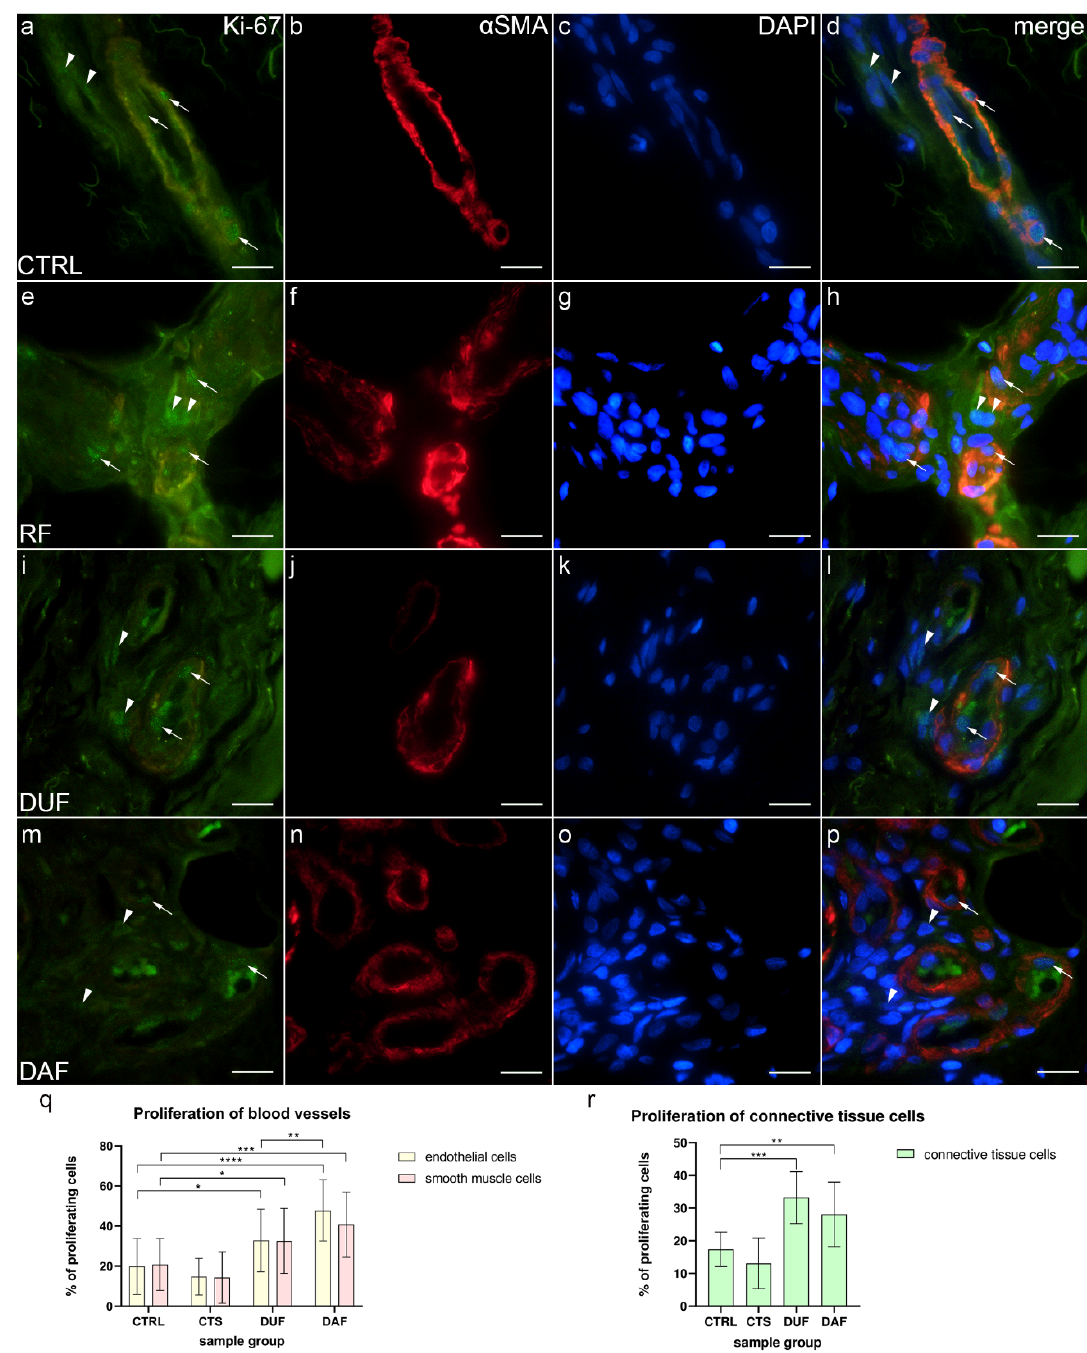
Figure 3. Co-expression of Ki-67 and α -SMA in connective tissues of patients with CTS and DD. CTRL–palmar fascia of CTS patients ( a – d ); RF–flexor retinaculum of CTS patients ( e – h ); DUF–clinically unaffected palmar fascia of DD patients ( i – l ); DAF–clinically affected palmar fascia of DD